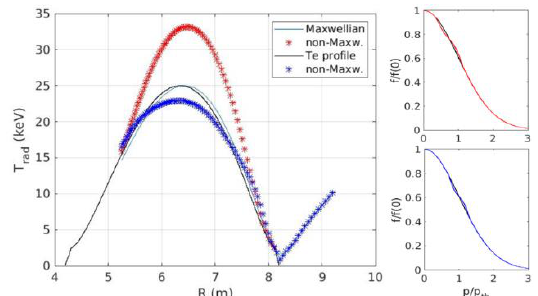
Fig. 14. 2 nd harmonic ECE temperature profile computed for an ITER plasma with T e0 = 25 keV (left panel). R is defined, for each frequency, as the cold resonance position. Input T e profile (black line). Maxwellian case (cyan line) and two examples obtained with perturbed distribution functions, with perturbation parameters: f 0 = 0.03,  /p th = 0.3, p 0 /p th = 0.75 (top right panel, red) and p 0 /p th = 1 (bottom right panel,